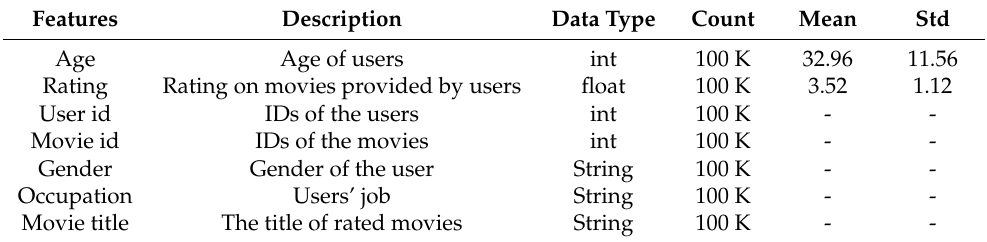
Table 1. MovieLens dataset information.